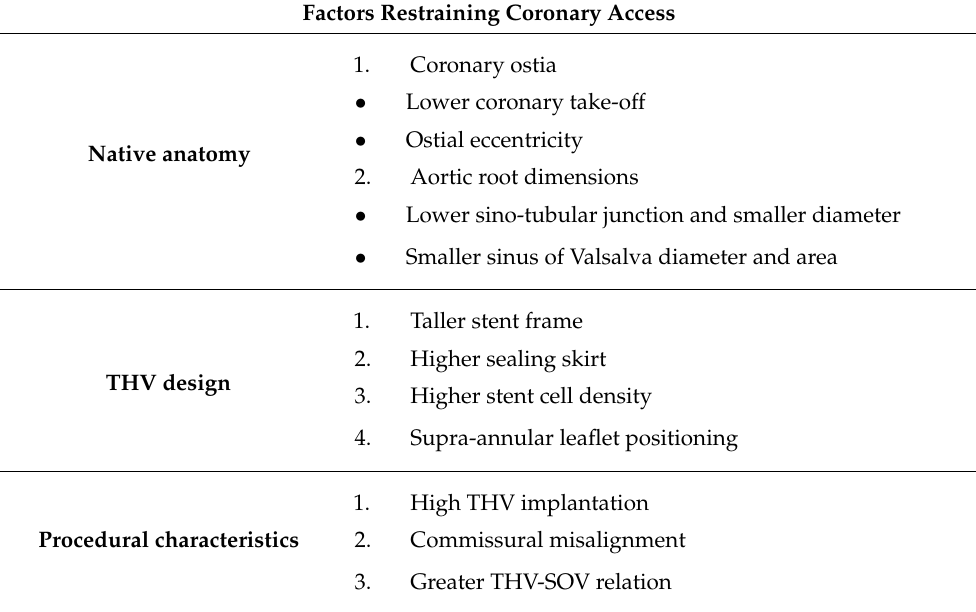
Table 1. Factors impacting coronary re-access with respect to patient ´ s anatomy, THV design